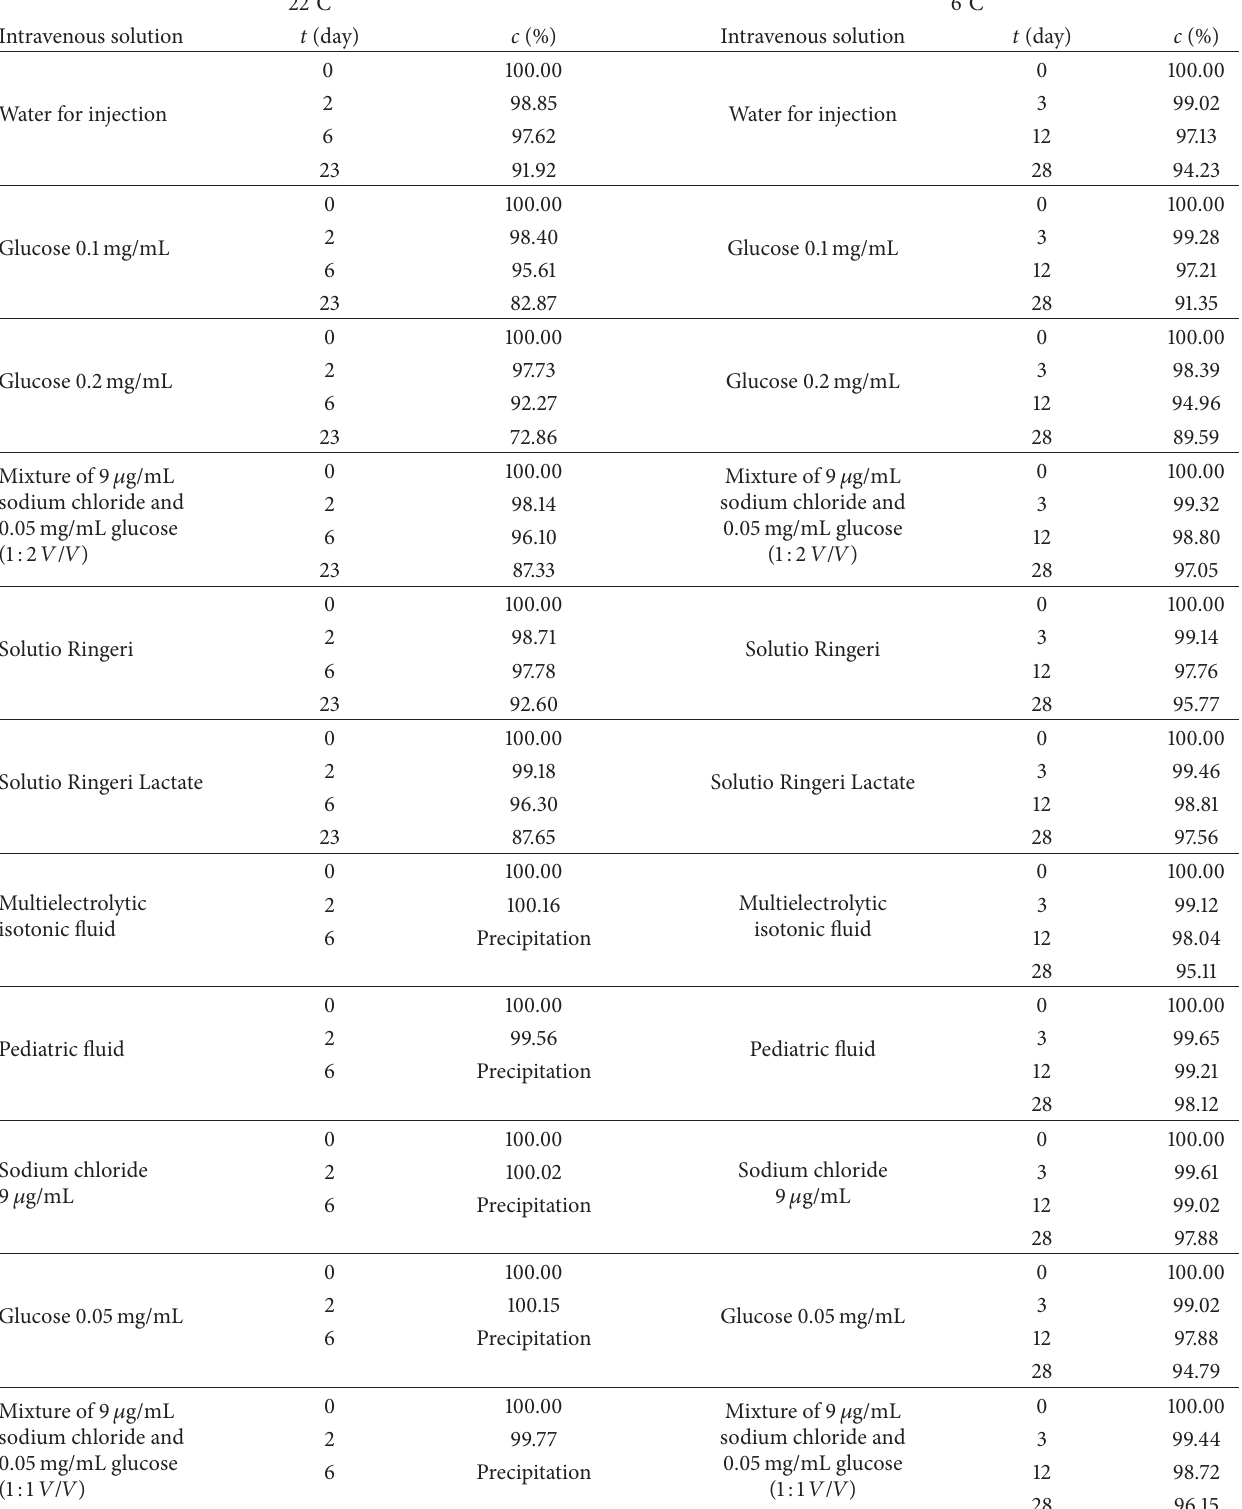
Table 1: Stability of ceftiofur sodium stored in poly(vinyl chloride)